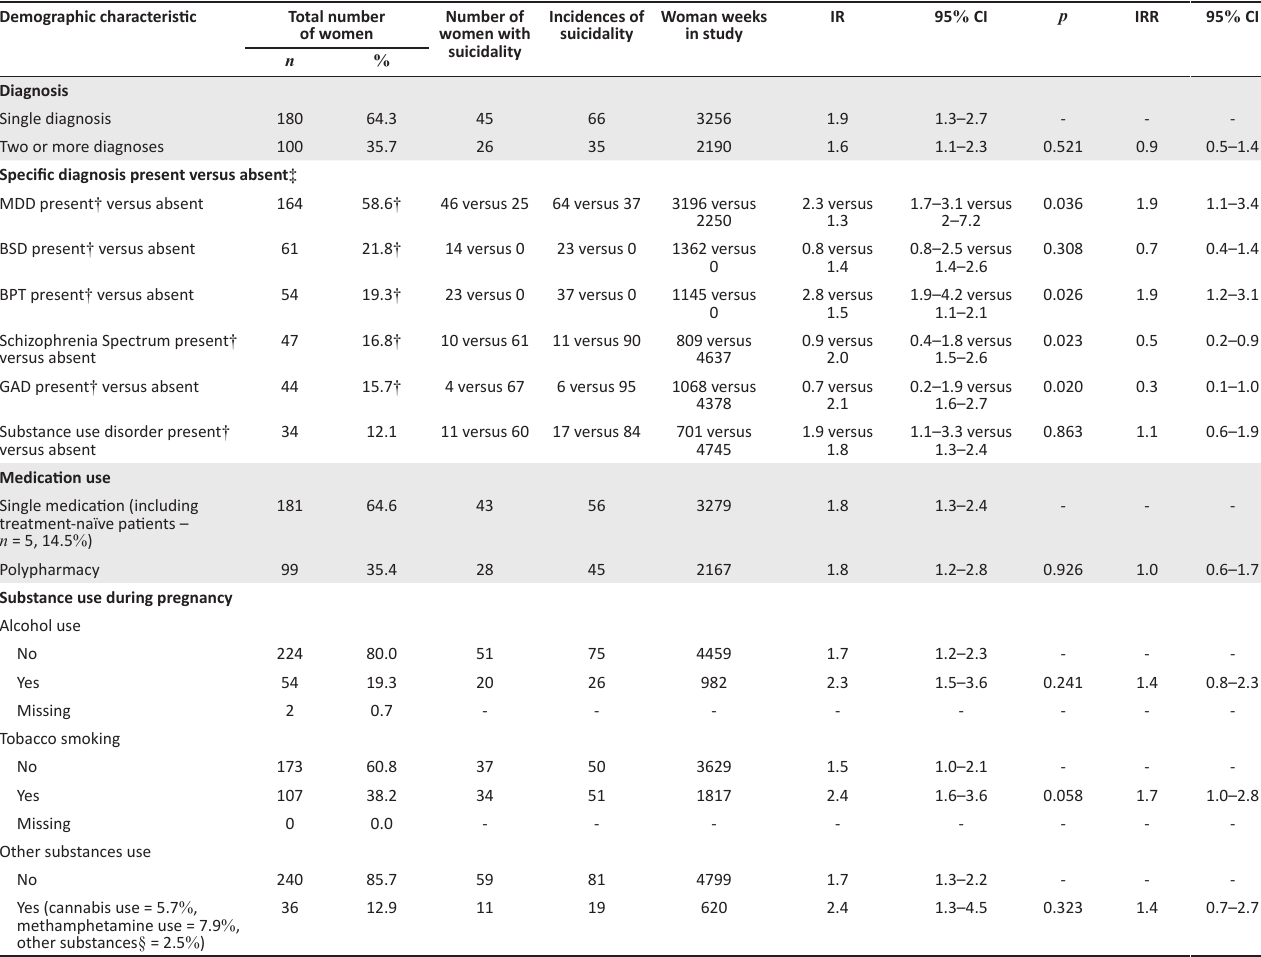
TABLE 2: The number of women, number of suicides and incidence of suicidality during pregnancy (incidence rate and 95 % confidence interval per 100 women weeks in the study) by psychiatric diagnosis and treatment. Demographic